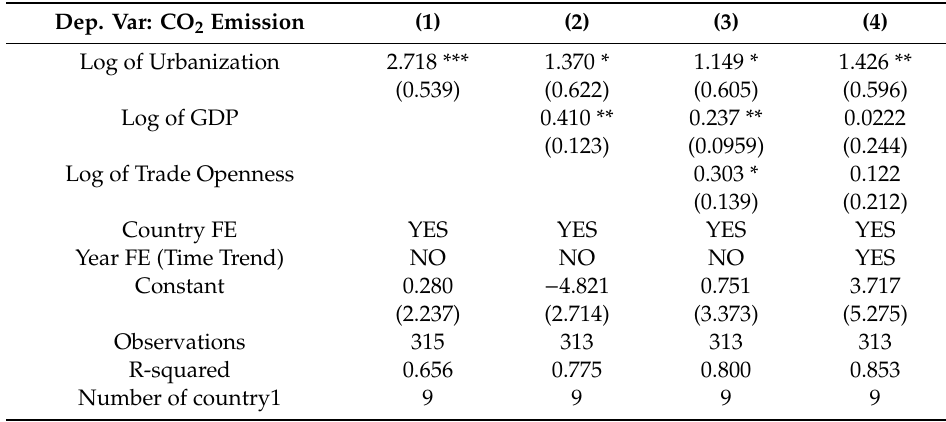
Table 2. Main determinants of carbon emission (CO 2 ) in Far-East Asian countries (fixed e ff ect